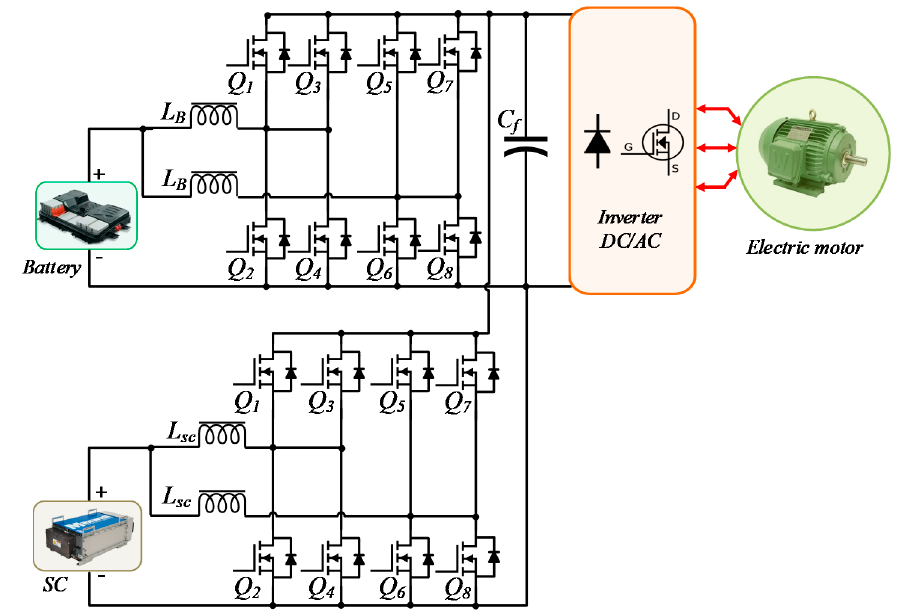
Figure 13. Multidevice Interleaved DC-DC Bidirectional Converter.